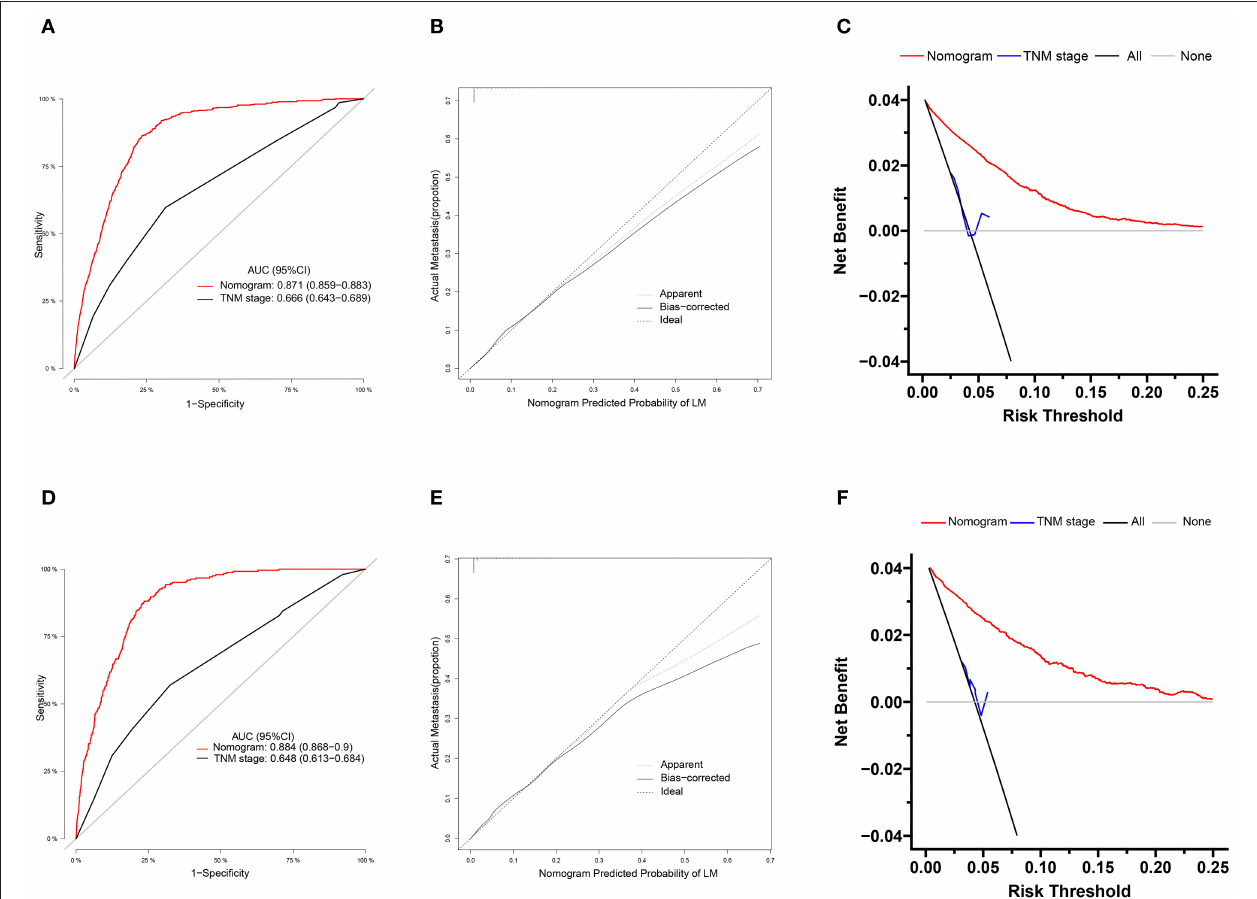
FIGURE 5 | ROC curves, calibration plots and decision curves of the nomogram for the risk of pancreatic cancer with lung metastasis. (A) The AUC was utilized to judge the advantages and disadvantages of nomogram. (B) Calibration plot for the diagnostic nomogram. The diagonal 45-degree line indicates perfect prediction. (C) Decision curve analysis for the diagnostic nomogram. The net benefit calculated by adding true positive and minus the false positive corresponds to the measurement of Y-axis; X-axis represents the threshold probability. (D–F) The AUC, calibration plot and decision curve in validation